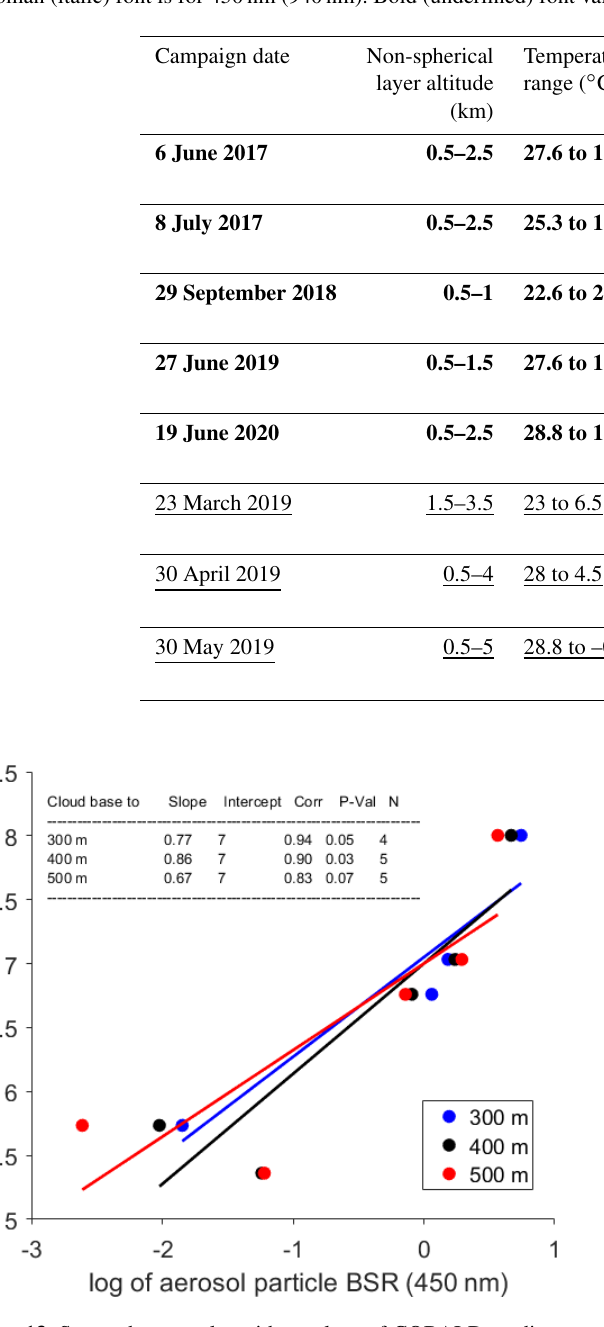
Figure 13. Scatter between logarithm values of COBALD median aerosol blue backscatter ( x axis) from 300, 400, and 500m below the cloud base and the corresponding CPS median cloud particle count ( y axis) obtained from five balloon soundings with a linear fit (different coloured lines). The inset shows detailed